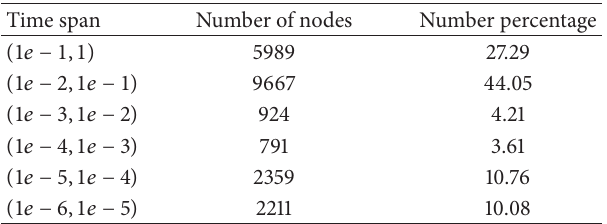
Table 1: The relation between time span and number of nodes with outdegree 1.